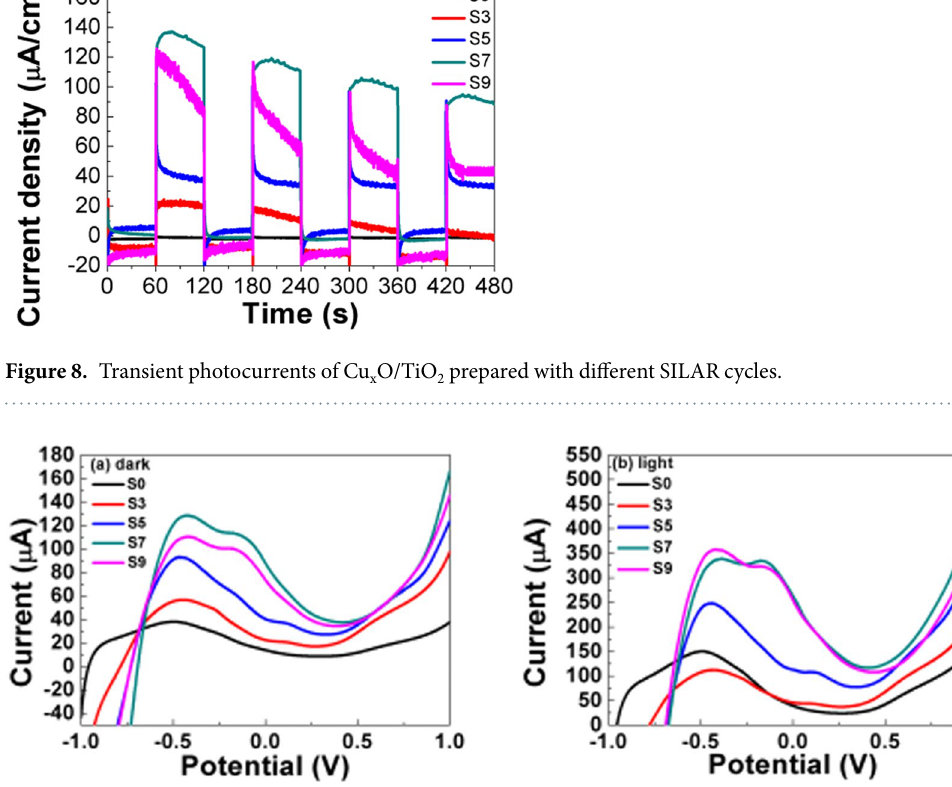
Figure 9. LSV spectra of Cu x O/TiO 2 electrodes in dark and under visible light